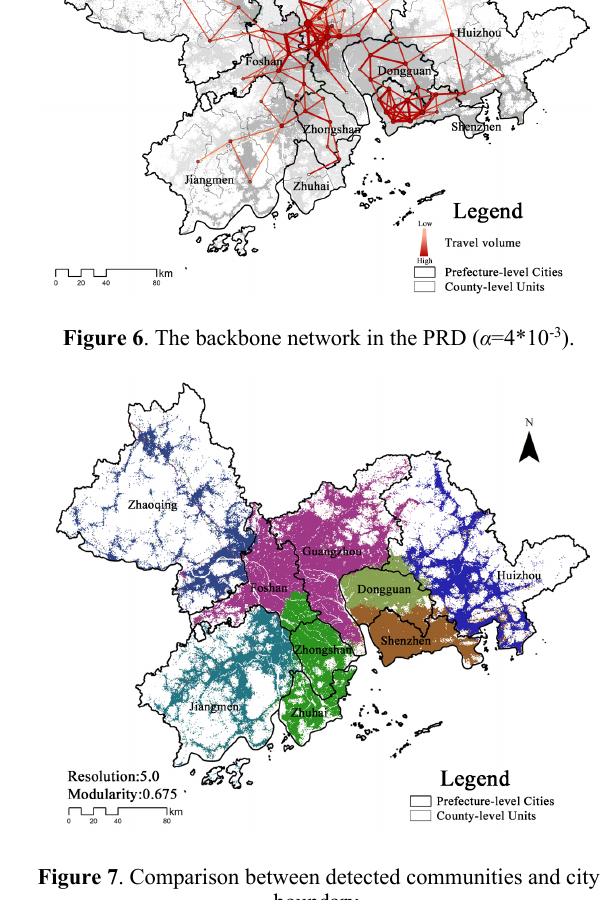
Figure 7 . Comparison between detected communities and city